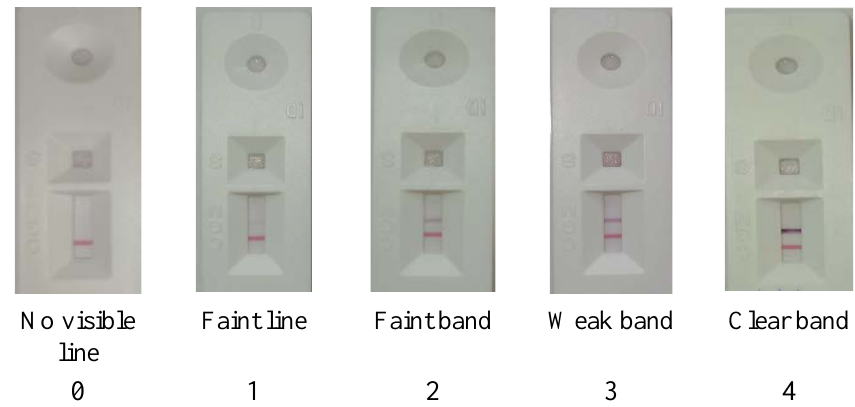
Figure Figure 1. Test line scoring of the qualitative detection of SARS-CoV-2 IgG with COVID-PRESTO ® (AAZ) based on intensity of lines.